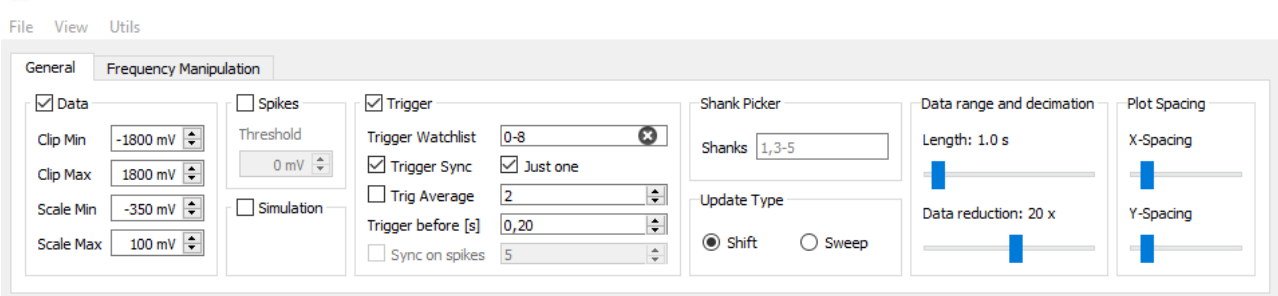
Figure 13. Graphical User Interface (GUI) of the Visualisation Client . The bottom window provides customisation of the visualisation parameters like input signal amplitude range, triggering, plot layout file and amount of data to present. The top window is the actual plot of data—in white, there are presented waveforms from the individual channels placed on the canvas according to the supplied layout file (some of them may be presented in different colours if they were marked by the user for better visibility); in red there is shown common trigger signal which can be chosen to align plot channel waveforms with the occurrence of the